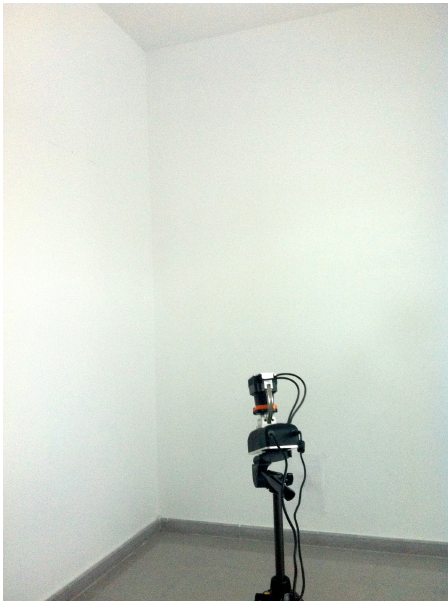
Figure 8. The corner of the office where 3D scans were